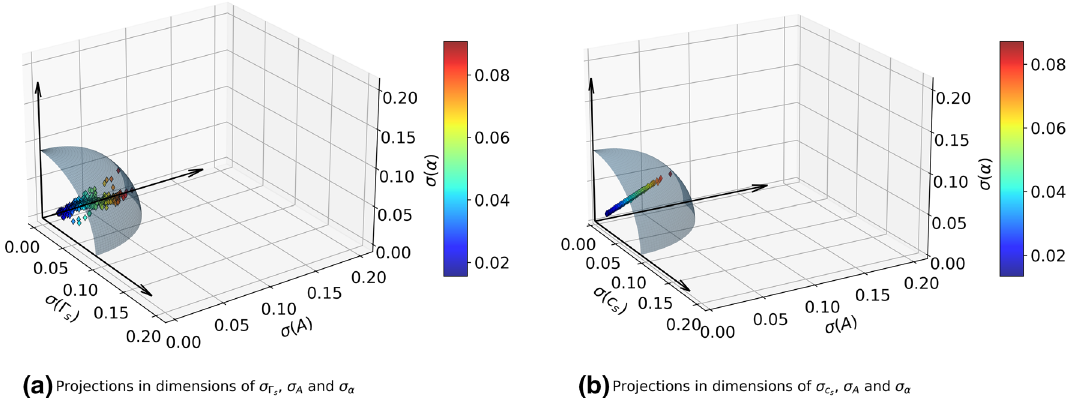
Figure 2. 3D projections of MSDs from the parameter hyperspace in normalized units. The colors of the points represents the Euclidean norms and shaded spherical surface encloses the region where σ < σ max